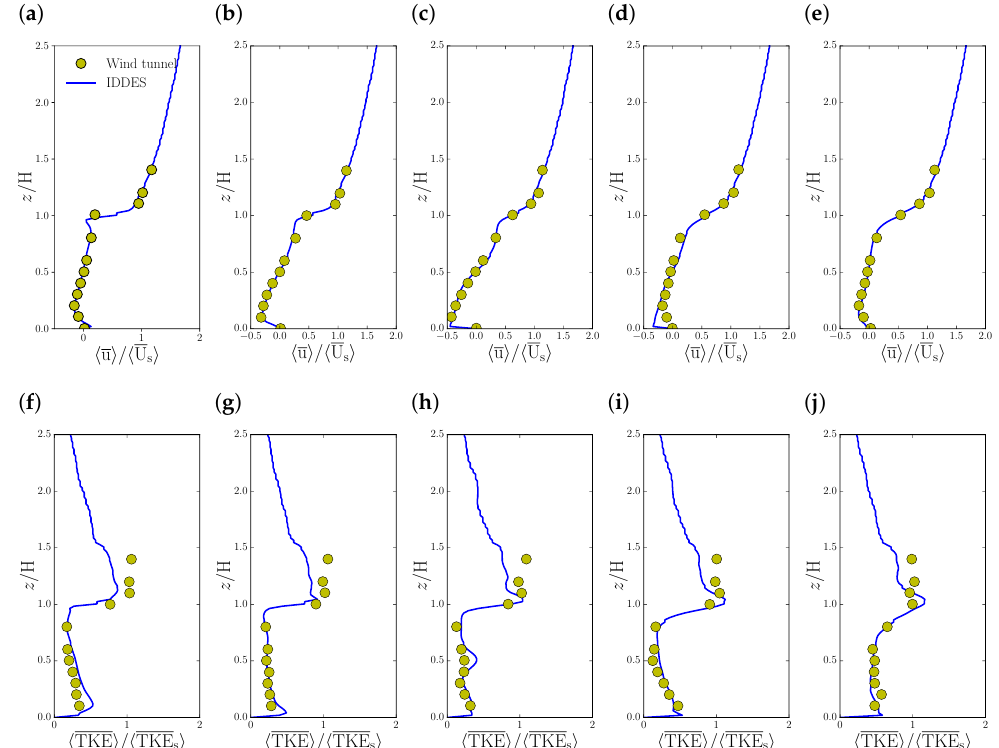
(Figure 2). Statistical performance measures [57] indicate a successful validation: fractional bias FB 0.02–0.05, the normalised mean square error NMSE 0.03–0.06, fraction of data ∼ ∼ FAC 2 0.9 and correlation coefficient R 1. Given that the vortex method is concerned ∼ ∼ with mean velocity profiles rather than fine-scale turbulence statistics, we conclude that the neutral-flow simulations with OpenFOAM can serve as a baseline truth against which the vortex method can be tested.